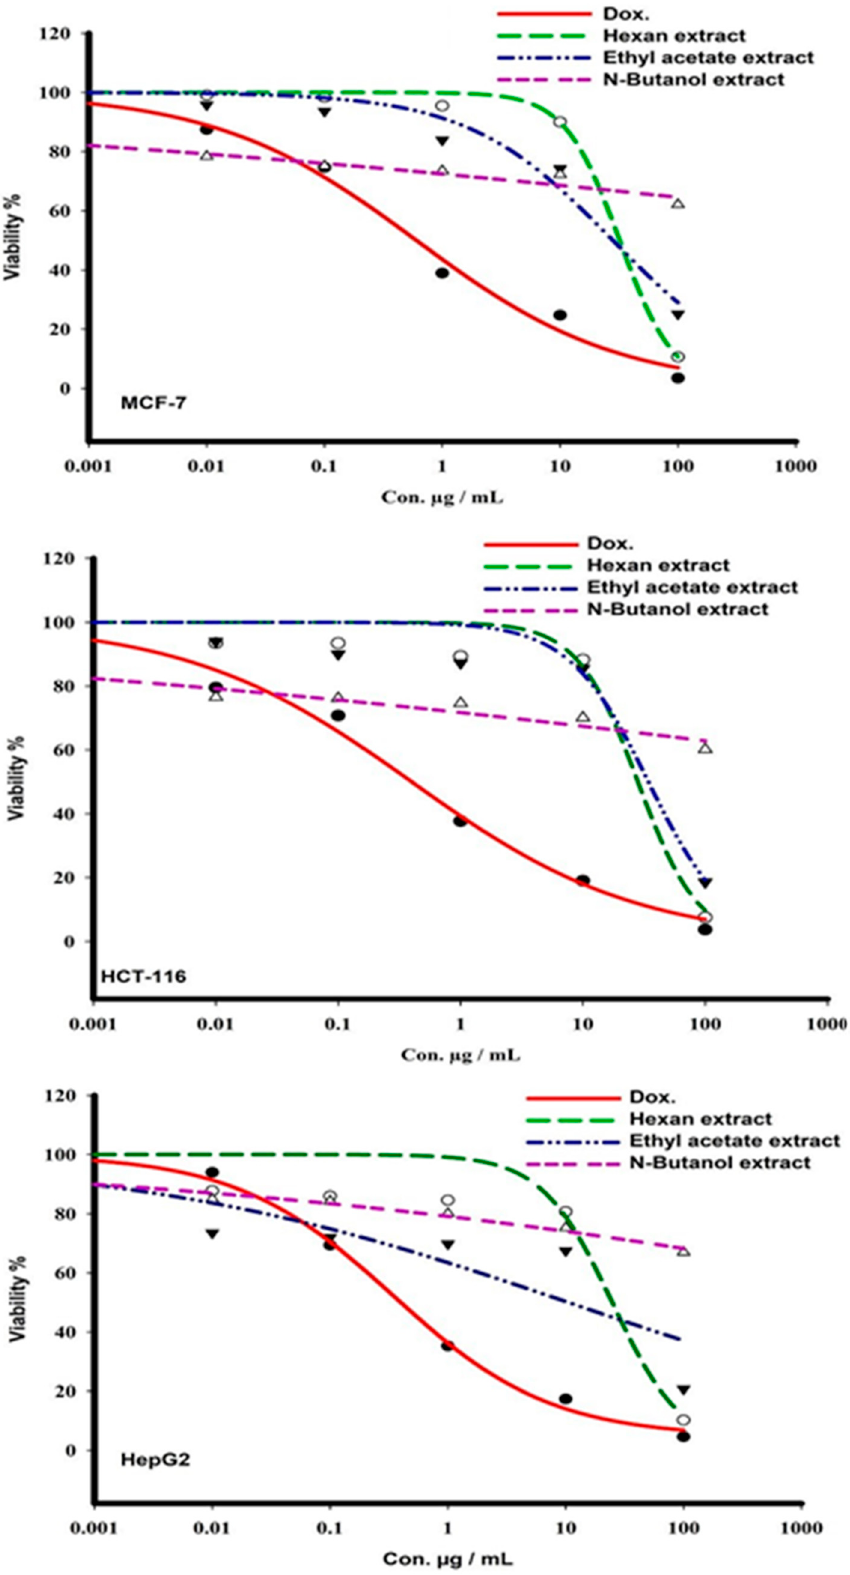
Figure 1. Dose-response curve of different extracts of A. lagopoides in solid tumor cell lines MCF-7, HCT-116, and HepG2. Cells were exposed to the extracts for 72 h. Cell viability was determined using SRB-U SulphoRhodamine-B assay and data are expressed as mean ± S.D. (n = 3).